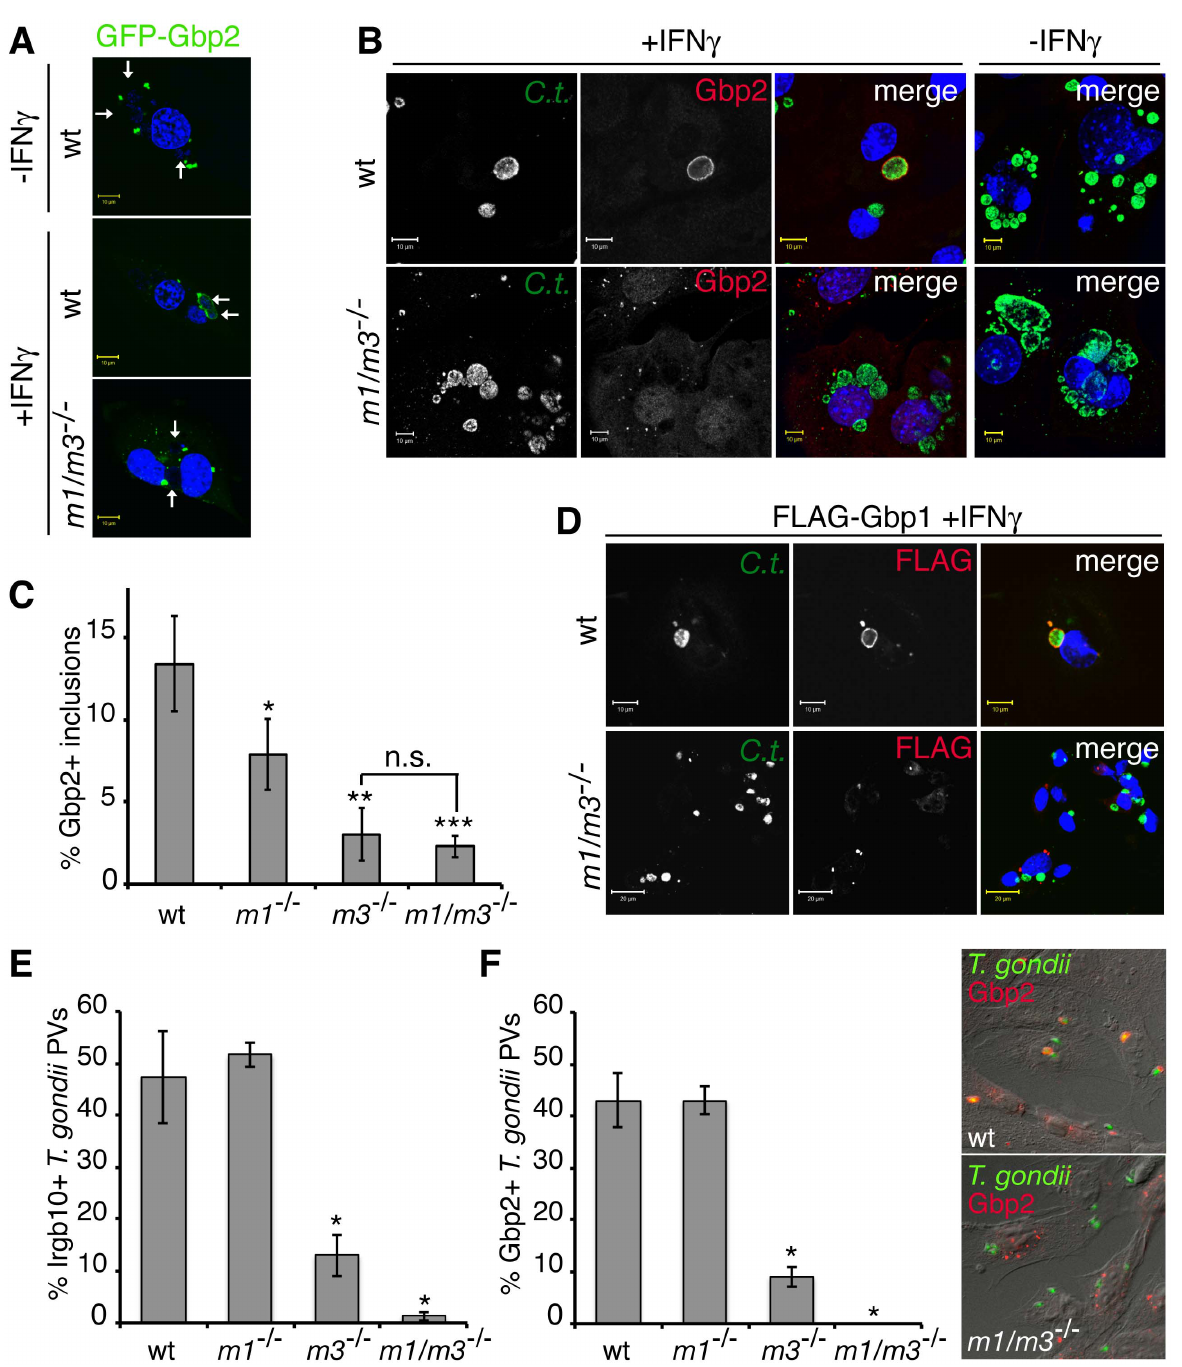
Figure 10. Irgm1 and Irgm3 are critical co-factors for the targeting of GBP proteins to C.trachomatis inclusions and T.gondii PVs. ( A ) Localization of ectopically expressed GFP-Gbp2 was monitored in C. trachomatis infected MEFs at 20 hpi. Arrows point at Hoechst-stained inclusions ( B ). Wildtype and Irgm1/m3 2 / 2 MEFs were infected with C. trachomatis , left untreated or treated with IFN c at 3 hpi. Cells were fixed at 20 hpi and stained with anti- C. trachomatis , anti-Gbp2 and Hoechst. ( C ) Co-localization of Gbp2 with inclusions in wildtype and Irgm1/m3 2 / 2 MEFs was quantified as described in Materials and Methods. Error bars represent standard deviations of three independent experiments. Statistical significance of group values relative to wildtype and between marked groups is shown (*, p , 0.05; **, p , 0.01; and ***, p , 0.005). ( D ) MEFs were transfected with FLAG-Gbp1, infected with C. trachomatis and activated with IFN c at 3 hpi. Cells were fixed at 20 hpi and stained with anti-FLAG and anti- C. trachomatis . Representative images are shown. ( E ) MEFs were treated overnight with 200 U/ml of IFN c prior to infections. Localization of endogenous Irgb10 to T. gondii PVs was monitored at 0.5 hpi. Data are representative of three independent experiments (*, p , 0.05 relative to wildtype). ( F ) Localization of endogenous Gbp2 to T. gondii was monitored at 0.5 hpi. Data are representative of three independent experiments (*, p , 0.05 relative to wildtype). Representative epifluorescent images of T. gondii -infected wildtype and Irgm1/m3 2 / 2 MEFs are shown.